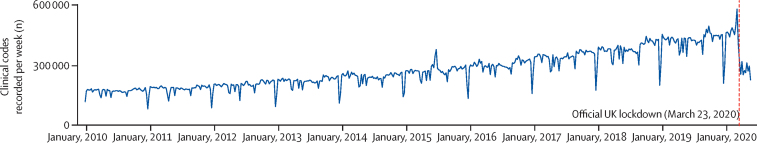
Number of clinical codes recorded in patient records per week, 2010–20Clinical codes included all symptoms, observations, diagnoses, prescriptions, operations, procedures, laboratory tests, and administration codes.